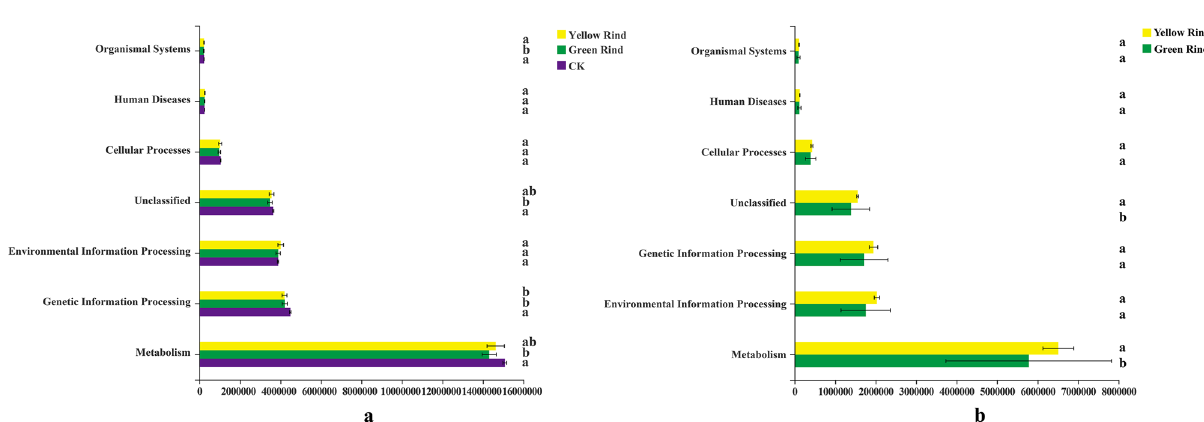
Figure 10. KEGG functional classification statistics of soil dominant bacteria in rhizosphere and endophytic bacteria between yellow and green rinds of watermelons (Pathway level 1). ( a ) KEGG functional classification statistics of soil dominant bacteria in rhizospheres of yellow, green rind watermelons and CK. ( b ) KEGG functional classification statistics of endophytic dominant bacteria in stems of yellow and green rind watermelons. Different letters in the same column indicate significant differences between treatments at p < 0.05 among the means of the different treatments. The horizontal coordinate indicates the abundance value and the vertical coordinate indicates the KEGG functional classification